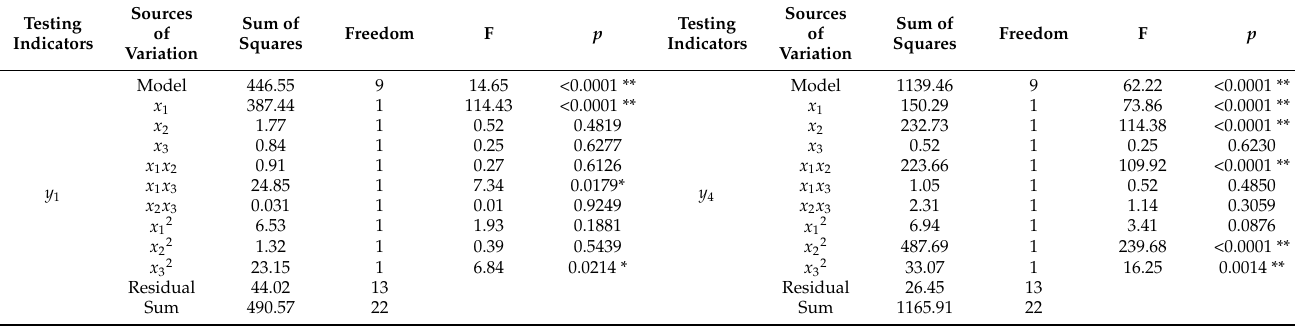
Table 7. Variance analysis of regression